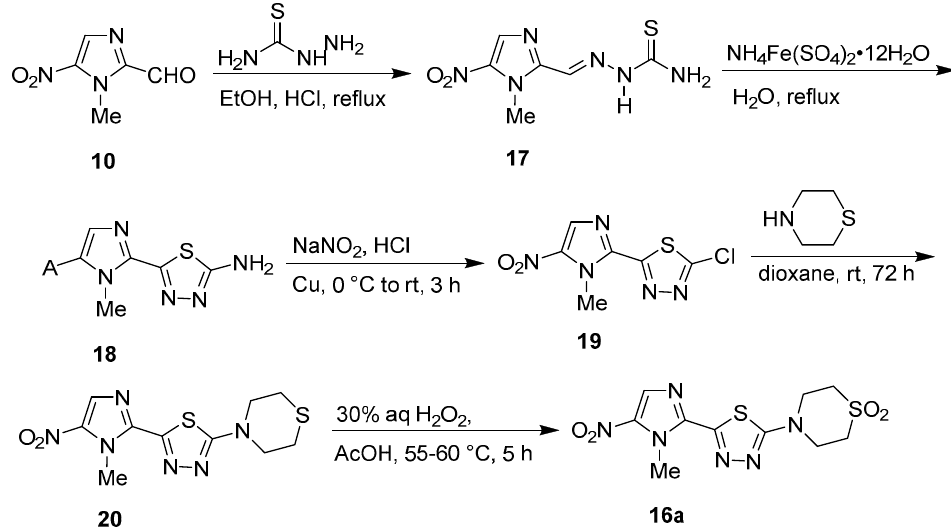
Scheme 4. Synthesis of 4-[5-(1-methyl-5-nitro-1 H -imidazol-2-yl)-1,3,4-thiadiazol-2-yl] thiomorpholine- 1,1-dioxide ( 16a ).